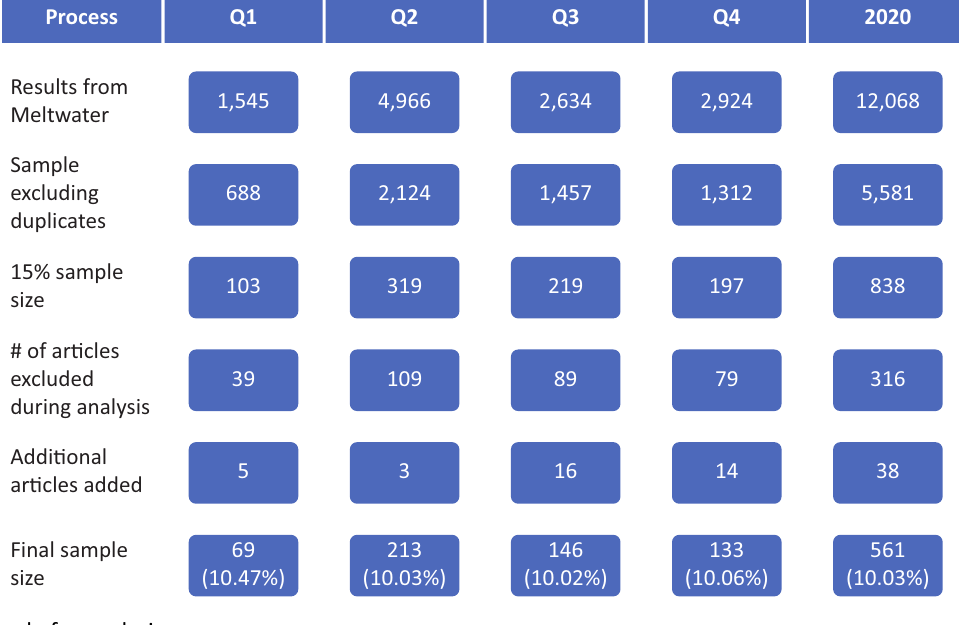
Figure 1. Sample for